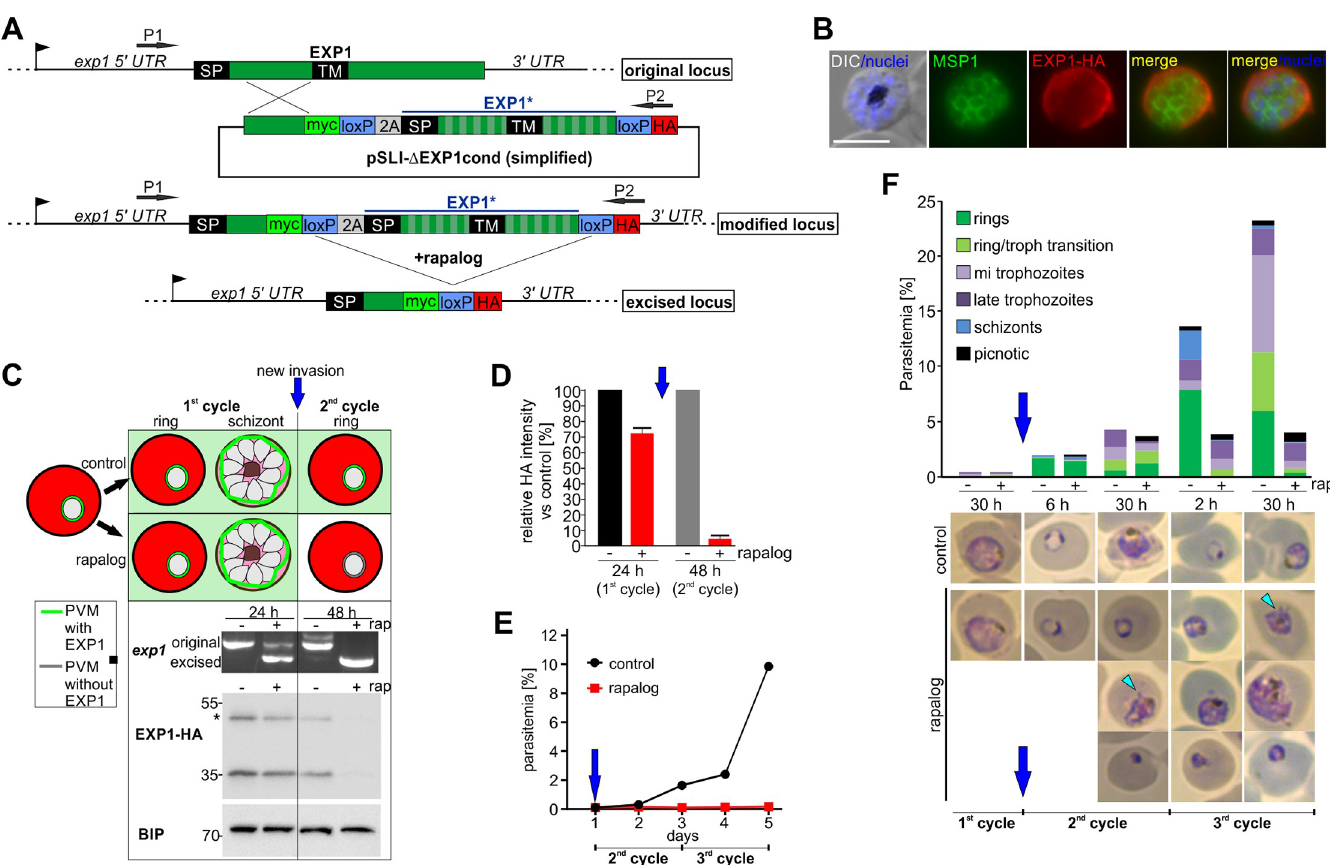
Fig 1. EXP1 is essential for blood stage development. (A) Simplified schematic of DiCre-based conditional exp1 KO using SLI. Arrows indicate primers P1 and P2 (see S1 Fig for details). (B) IFA of compound 2-arrested cond Δ EXP1 late-stage schizonts show localization of EXP1 � -HA at the PVM. α -MSP1 (MSP1) labels the PPM. Nuclei were stained with DAPI; scale bars, 5 μ m. (C) Strategy for depletion of EXP1 from the PVM of synchronized cond Δ EXP1 ring stages divided into a culture with rapalog (“rap”) and one without rapalog (“control”). Top: schematic: green boxes and green line signify PVM with EXP1. Mid: PCR with primers P1 and P2 from gDNA 24 and 48 hours after addition of rapalog. Original: band for intact exp1 locus (1,919 bp); excised: band after excision of exp1 � (1,326 bp). Bottom: western blot probed with α -HA to detect EXP1 � -HA and α -BIP as loading control. Asterisk: unskipped (first T2A) product that is present before excision and hence has no impact on parasites. (D) Quantification of levels of wtEXP1-HA in the first ("24 h") and second ("48 h") cycle after addition of rapalog based on densitometric analysis of anti-HA immunoblots (mean of n = 2 independent experiments) of which one is shown in (C). HA signal was normalized to BIP. Error bars indicate SD. (E) FC growth curves of synchronous ring stage cond Δ EXP1 parasites starting in cycle 2 ( Δ EXP1 parasites) as shown in (C). One representative of n = 5 independent experiments. (F) Stage distribution of cond Δ EXP1 parasites in Giemsa smears of synchronous parasites grown with (+) and one without ( − ) rapalog (“rap”) at different time points (average time post invasion) after adding rapalog. Light blue arrowheads show blebs. One of n = 4 independent experiments is shown. Blue arrow in (C–F) indicates start of a new cycle without EXP1. 2A, T2A skip peptide; BIP, binding immunoglobulin protein; DIC, differential interference contrast; DiCre, Dimerizable Cre; EXP1, exported protein 1; EXP1 � , recodonized exp1 ; FC, flow cytometry; gDNA, genomic DNA; HA, triple hemagglutinin tag; KO, knockout; MSP1, merozoite surface protein 1; PPM, parasite plasma membrane; PVM, parasitophorous vacuolar membrane; SLI, selection-linked integration; SP, signal peptide; TM, transmembrane domain; wt, wild-